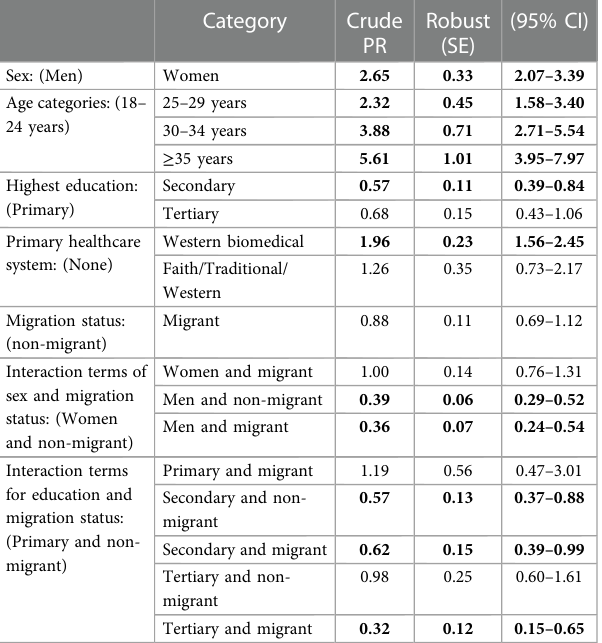
TABLE 4 Multimorbidity prevalence ratios for socio-demographic and health factors in a rural population, South Africa ( N